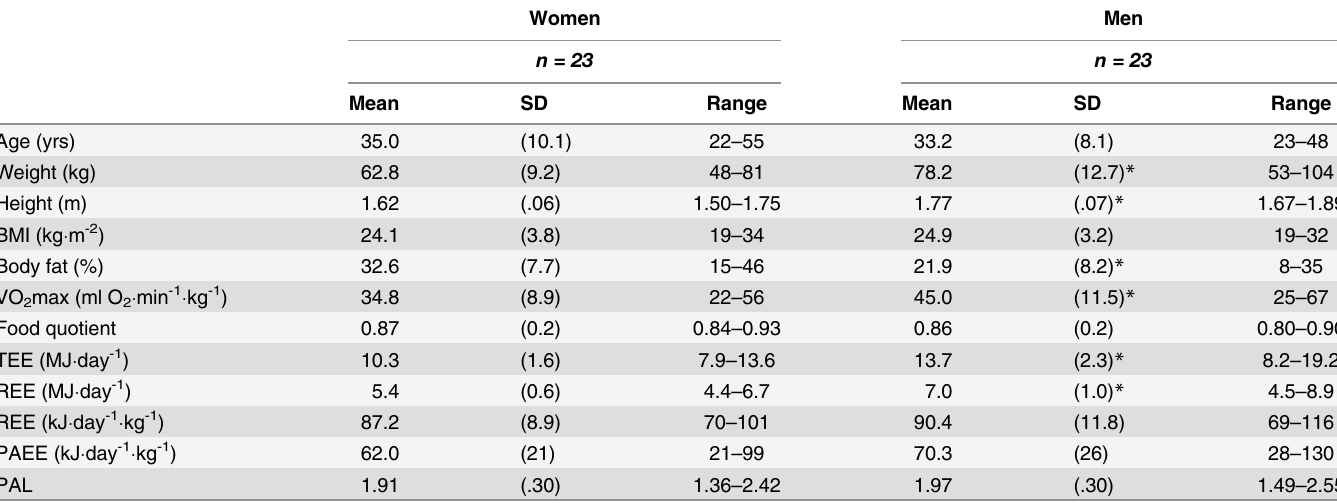
Table 1. Participant characteristics.